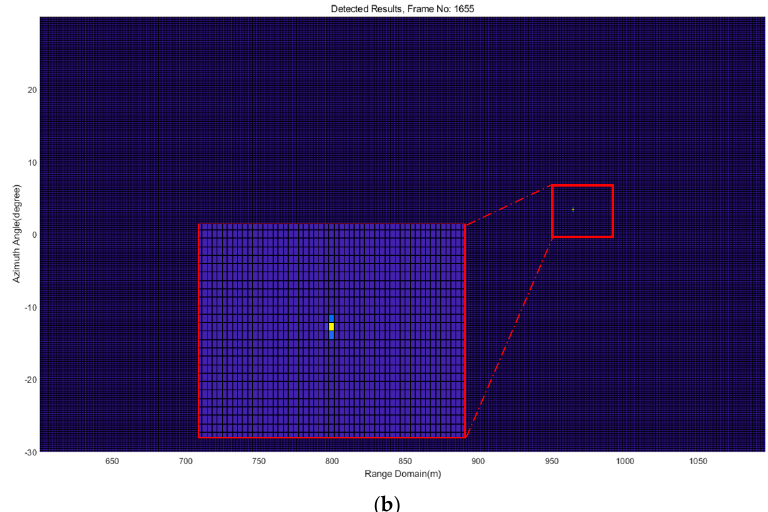
Figure 17. Illustration of one frame of detection results of Experiment 1, ( a ) range-Doppler map; ( b ) range-angle map.